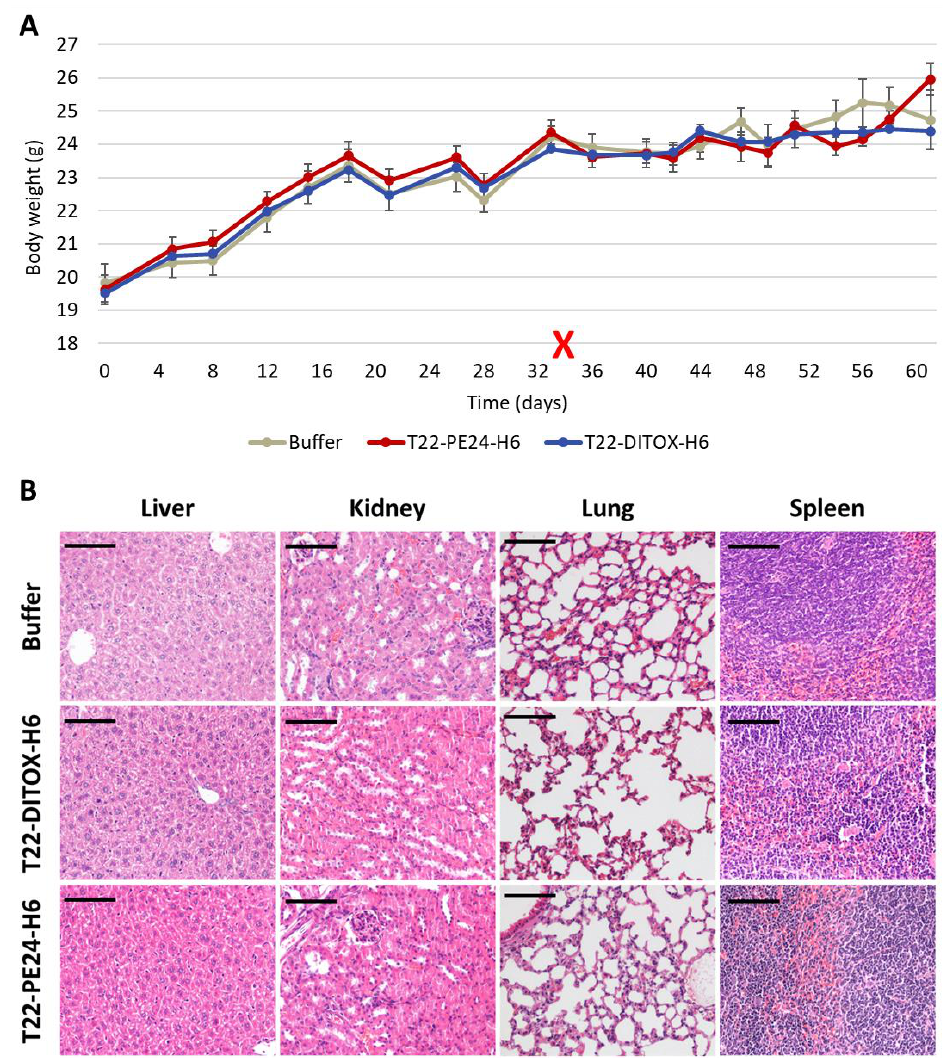
Figure 5. T22-DITOX-H6 and T22-PE24-H6 did not induce systemic toxicity in the CXCR4 + AN3CA subcutaneous EC model. ( A ) Body weight evolution over time did not show differences between control and nanotoxin-treated mice. The red cross indicates the end of treatment administration. ( B ) Hematoxylin-eosin staining of non-tumor organs 48 h after the last nanotoxin administration showed normal tissue architecture and, therefore, a lack of histological alterations and lack of protein deposition. Bar: 100 µm.